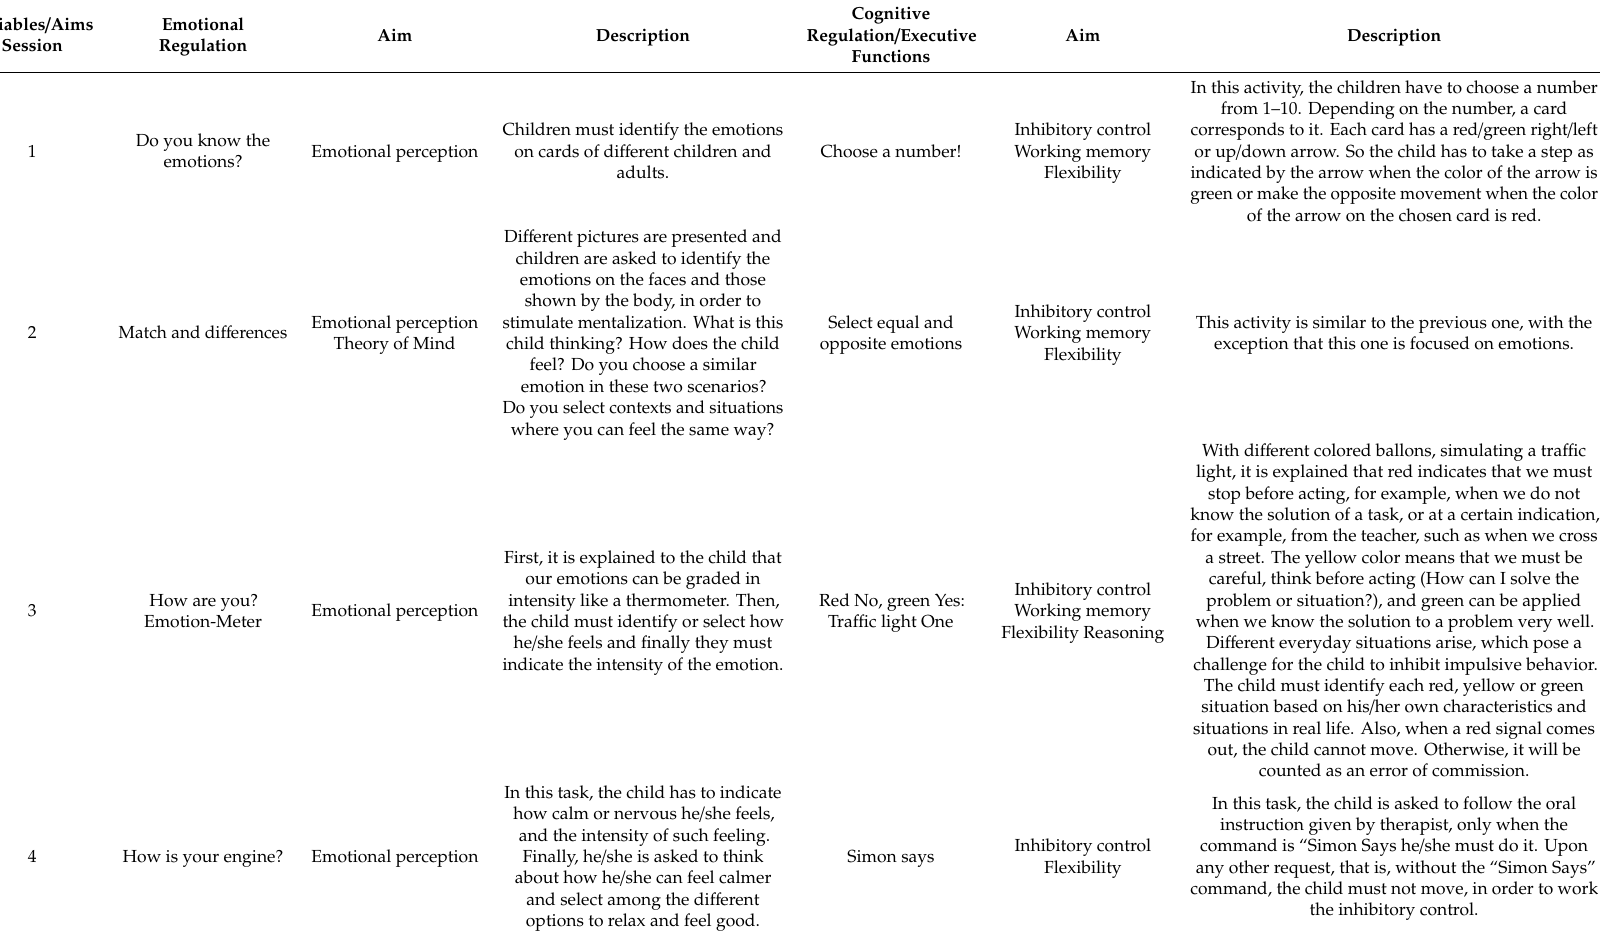
Table 3. Organization, description and aims of each session for Control